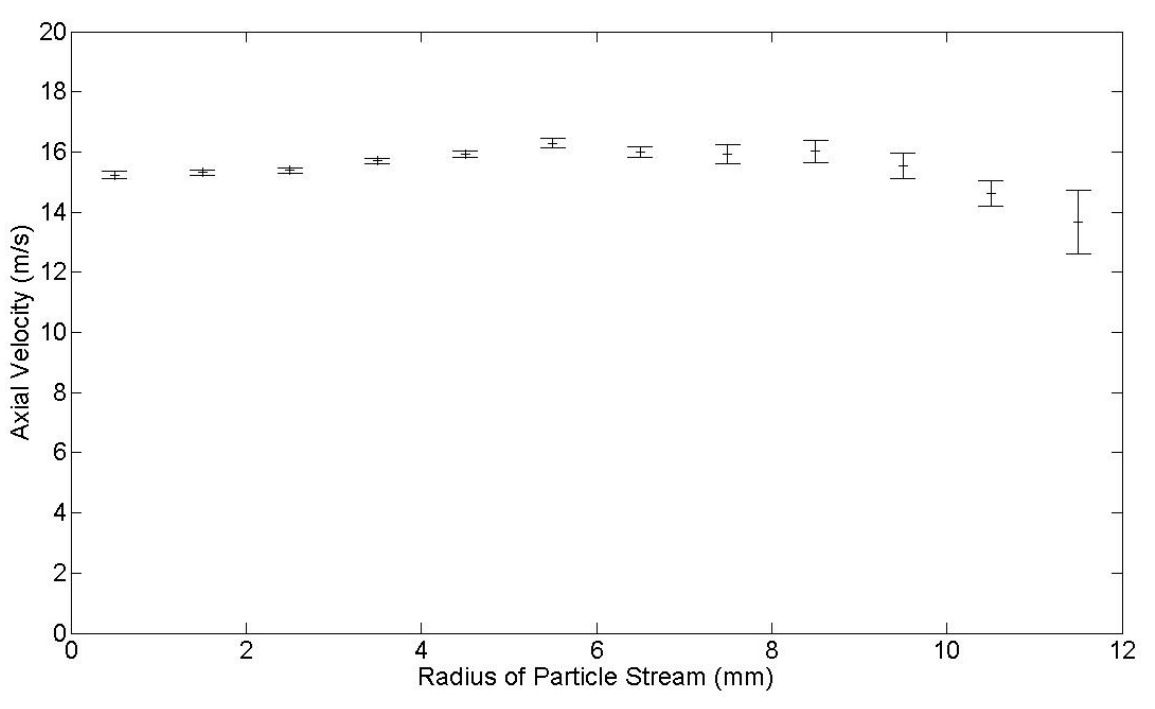
Figure 21. Experiment 1: Numerical simulation of two phase flow. The particle ( a ) axial and ( b ) radial velocities at 20 cm from the origin of the annular air jet averaged over 1 mm radial